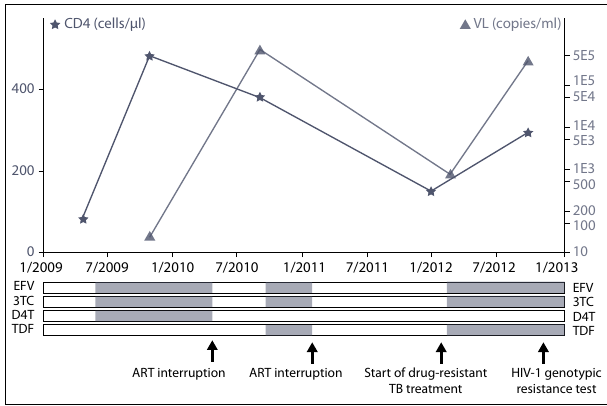
Fig. 1. Clinical course of ART with results of viral load (VL) and CD4 + cell count monitoring and timing of treatment